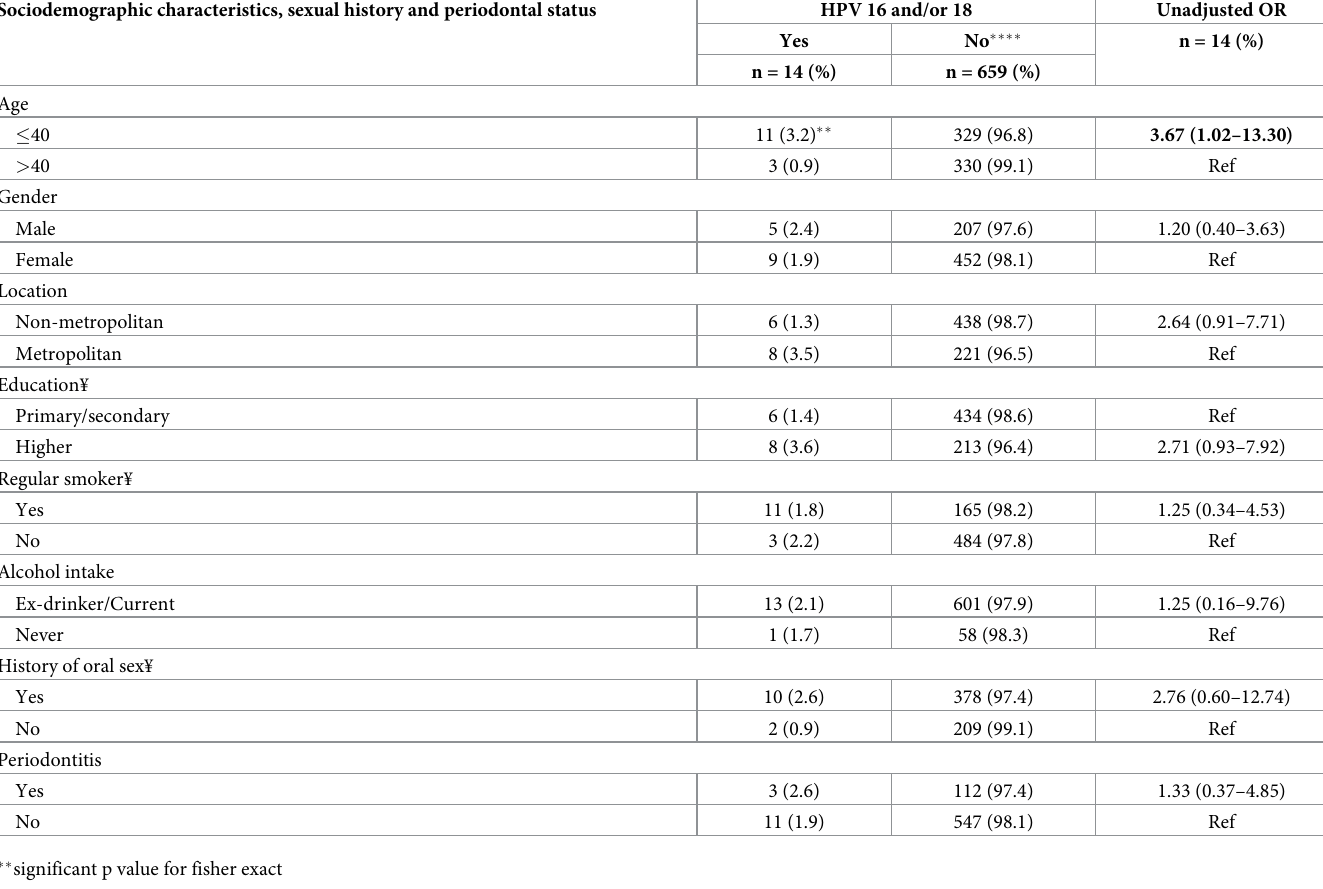
Table 3. Bivariate association between sociodemographic and periodontitis with HPV 16 and/or 18 (N = 673). Sociodemographic characteristics, sexual history and periodontal status